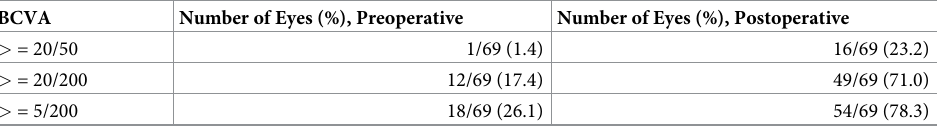
Table 6. Visual function comparing preoperative and postoperative visual acuity (n =